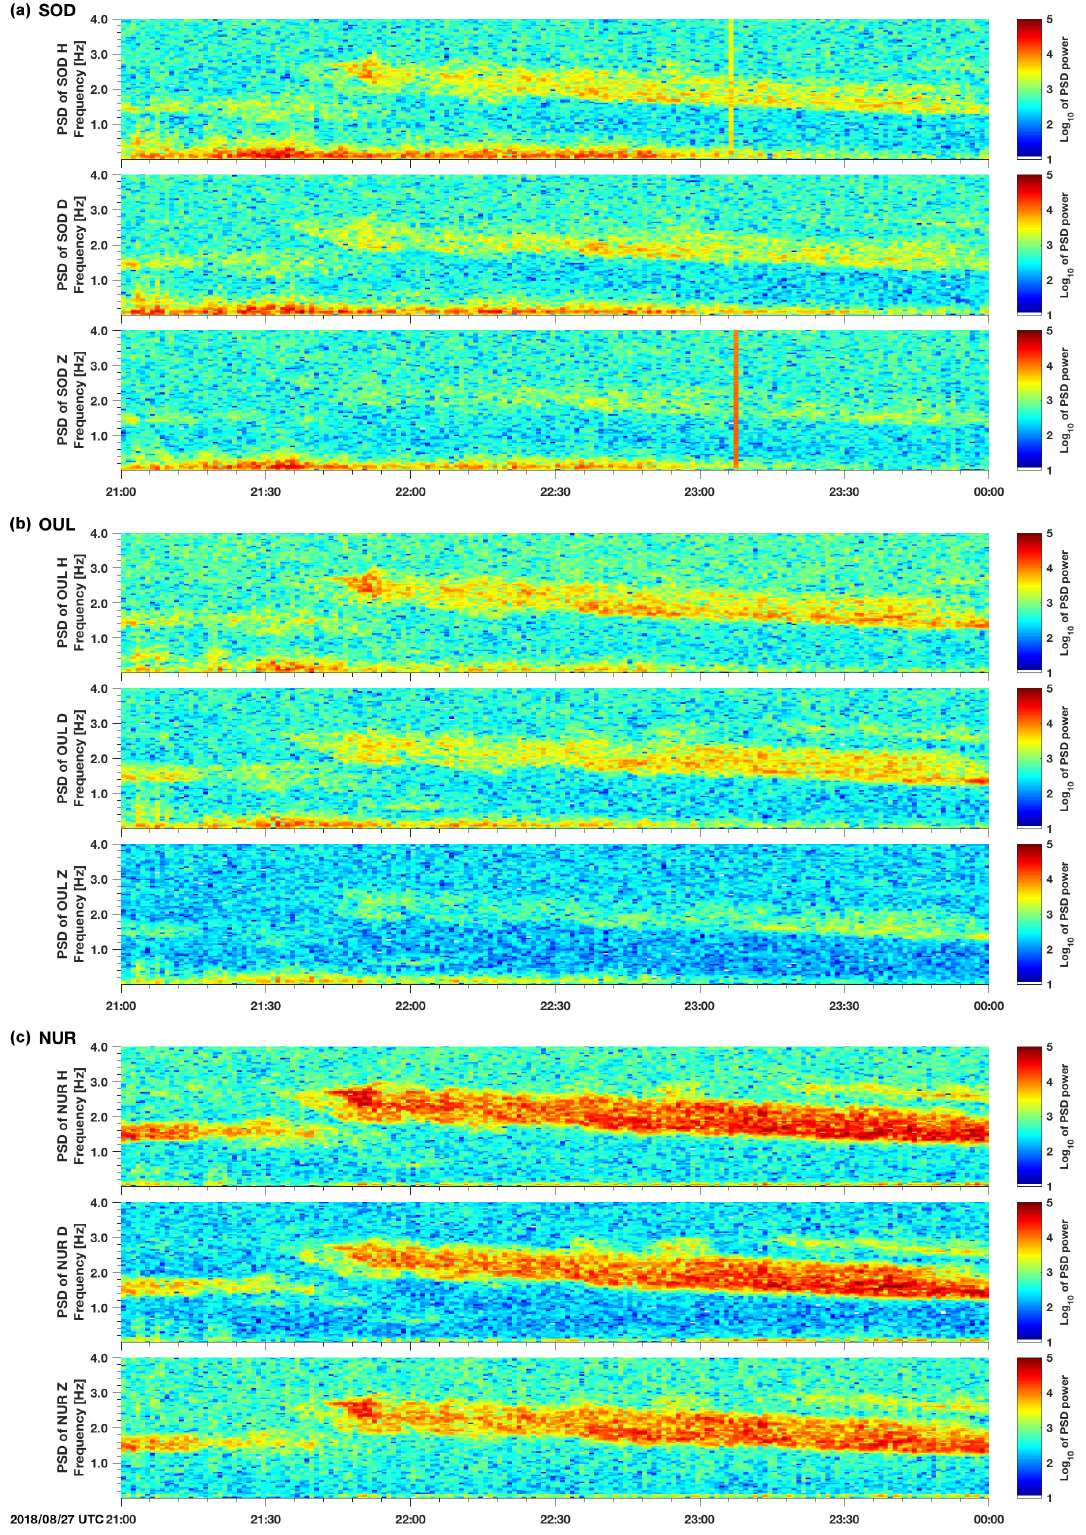
Figure 6. The power spectral densities (PSDs) of the magnetic fields in the local north-east-up (NEU) coordinates during the Pc1 waves period (21:35–24:00UTC) observed by the SGO ground stations at different L -shell